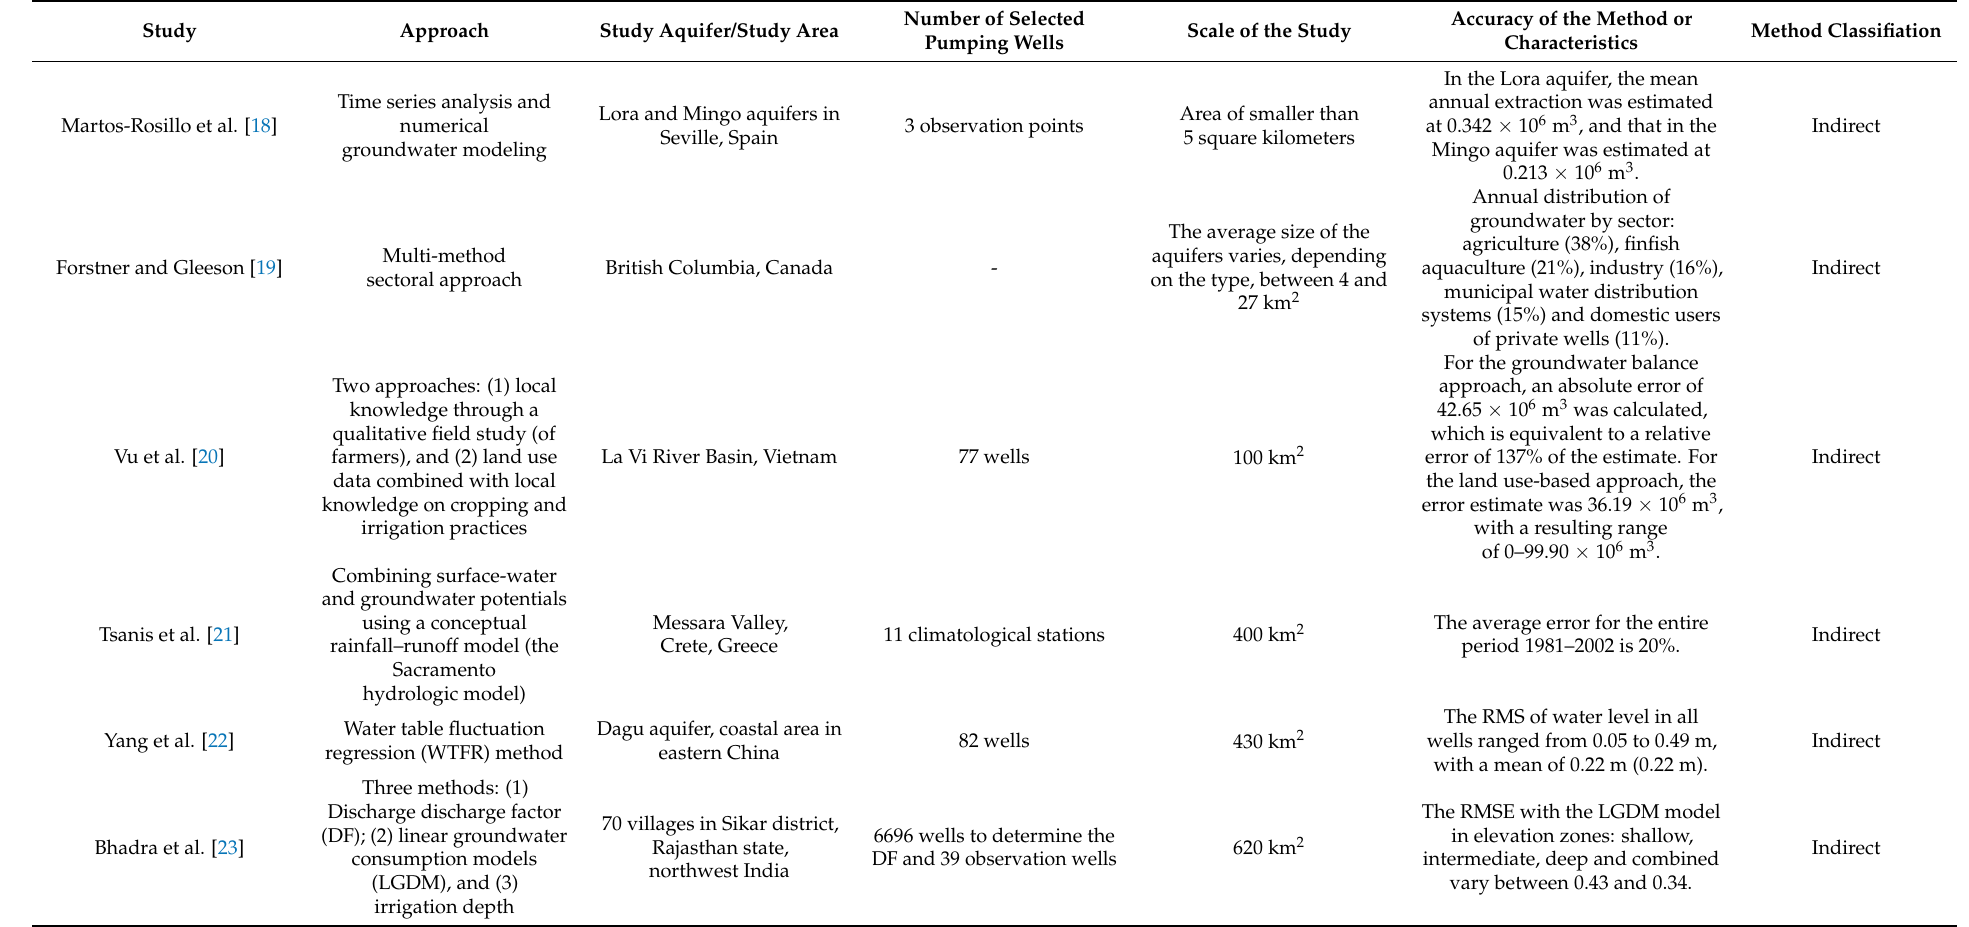
Table 1. Methodologies identified for pumping estimation as a function of the used approach. Root mean square (RMS); coefficient of determination (R 2 ); mean absolute error (MAE); root mean square error (RMSE); not specified